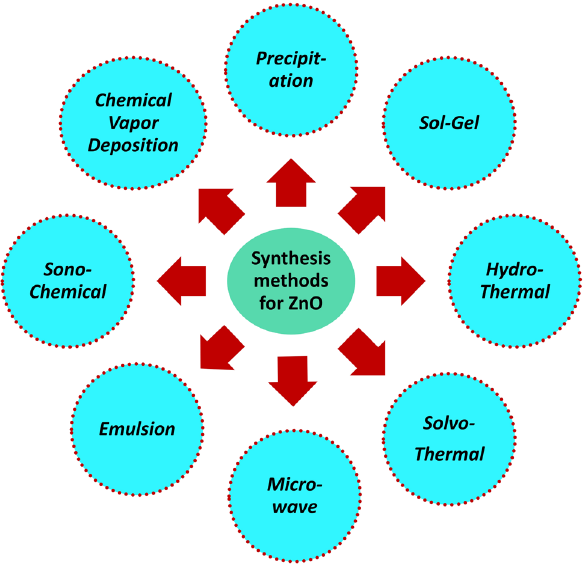
Figure 2: Di ff erent synthesis methods used for the development of di ff erent ZnO